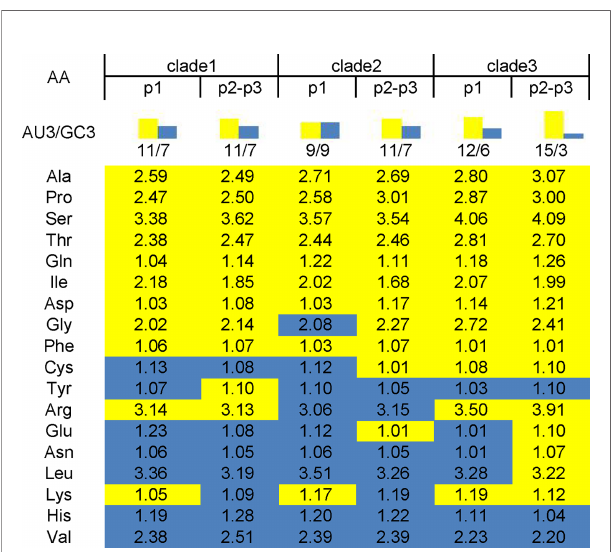
FIGURE 2 | AU3 and GC3 in codons of P1 and P2P3 regions of EV-A clade 1, clade 2 and clade 3. Numbers in the square array indicate the RSCU values of preferred codon by each amino acid. Yellow shade indicate AU3 and blue shade indicate GC3 for the codon ending.